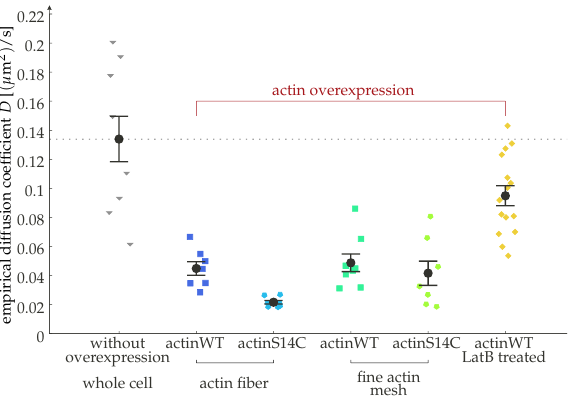
Figure 3. Experimental evidence for how receptor dynamics can be modulated by the subplasmalem- mal environment, in particular for the cortical actin mesh, showing the diffusion coefficient of the β 2 -adrenergic receptor ( β 2 -AR) in rat myoblast H9c2 cells for different regions of the cell and condi- tions. The β 2 -AR is significantly slower in cells overexpressing actin. When actin is hyperpolimerized, using the mutant S14C, the diffusion is additionally reduced. The receptors are slowest around large actin bundles (fibers). We added a dashed line corresponding to the wild-type findings to highlight the effect of actin overexpression. Actin depolymerization by Latrunculin B (2 µ M) leads to a statistically significant recovery in the diffusion rate of the receptor. Error bars indicate the standard error of the mean. This figure reproduces data from